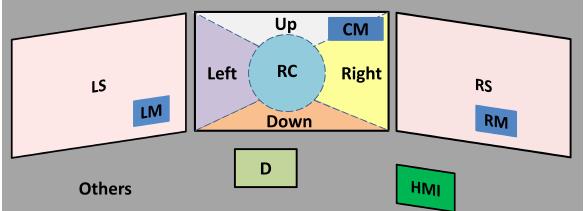
Figure 3: Division of the driving environment in 13 areas of in-